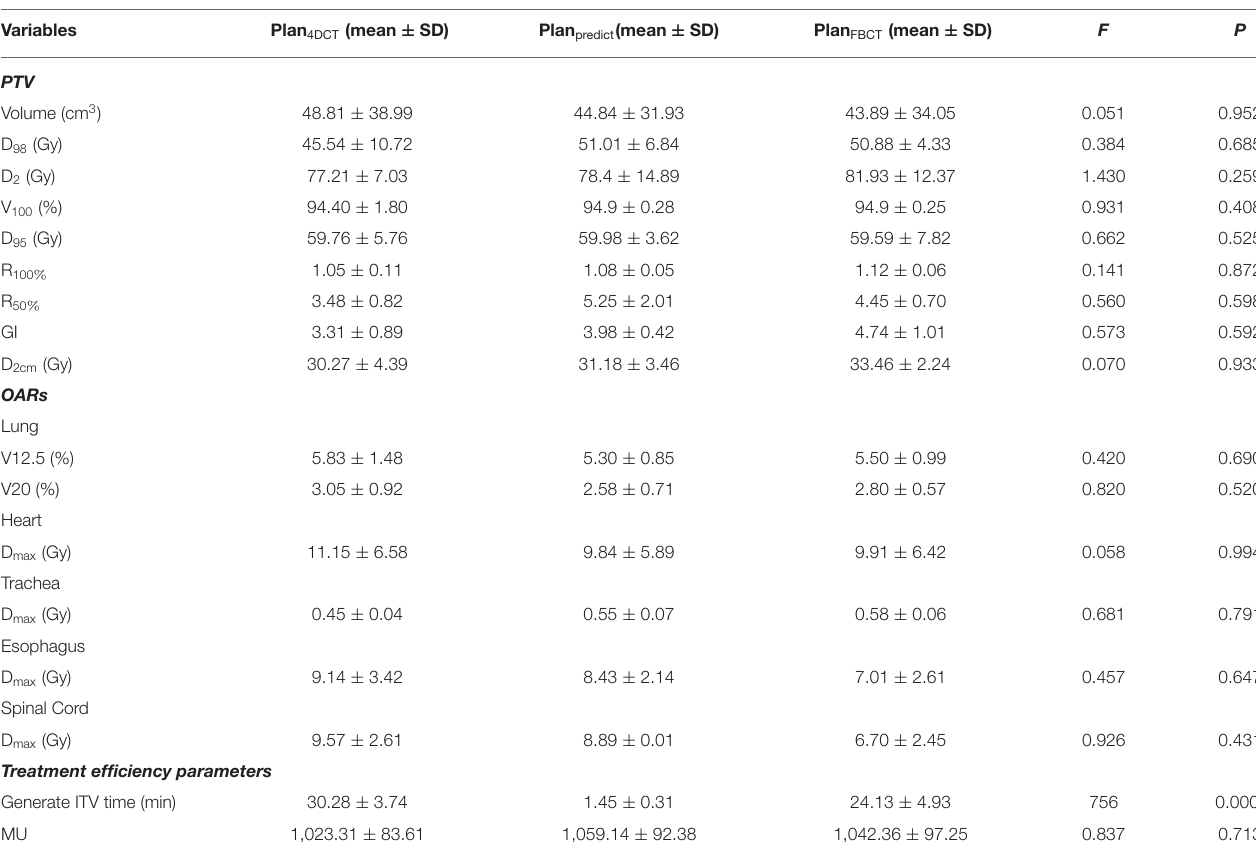
TABLE 5 | Dosimetric parameter comparison among Plan 4DCT, Plan predict , and Plan FBCT